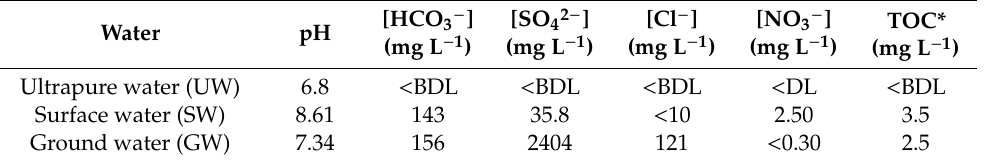
Table 2. Chemical characteristics of the water matrix.